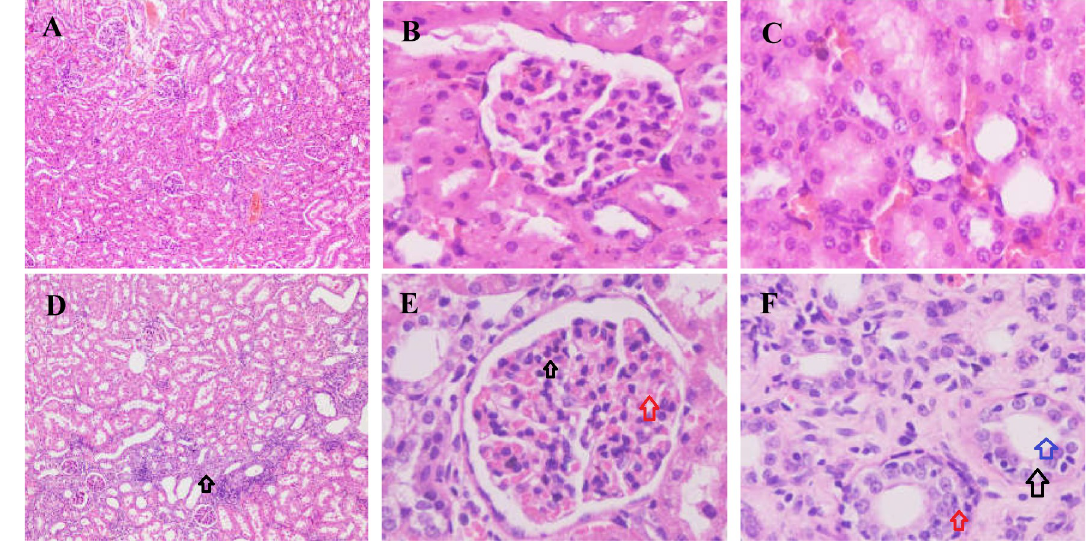
Fig 11. Histological examination of the kidney sections. Organ sections were stained with hematoxylin-eosin (HE). Interstitial hyperplasia was frequently found (D, the black arrow). The swollen glomeruli, the thronged erythrocytes (the red arrow) in the glomeruli, and the proliferated glomerular cells (the black arrow) were often found (E) in the Uox -/- rats’ kidney sections. The enlarged tubules (the blue arrow), swollen tubular walls (the red arrow) and proliferated renal cells (the black arrow) were also frequently seen in the Uox -/- rats’ renal interstitial tissue (F). A-C, the kidney of the wild-type rat and D-E, the kidney of the Uox -/- rat. Picture (A and D) = 1040 μ m × 1400 μ m; and Picture (B, C, E, and F) = 130 μ m × 175 μ